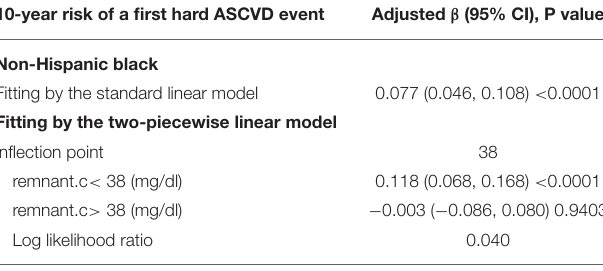
TABLE 4 | Threshold effect analysis of Remnant-C on 10-year risk of a first hard ASCVD event in non-Hispanic blacks using the two-piecewise linear regression